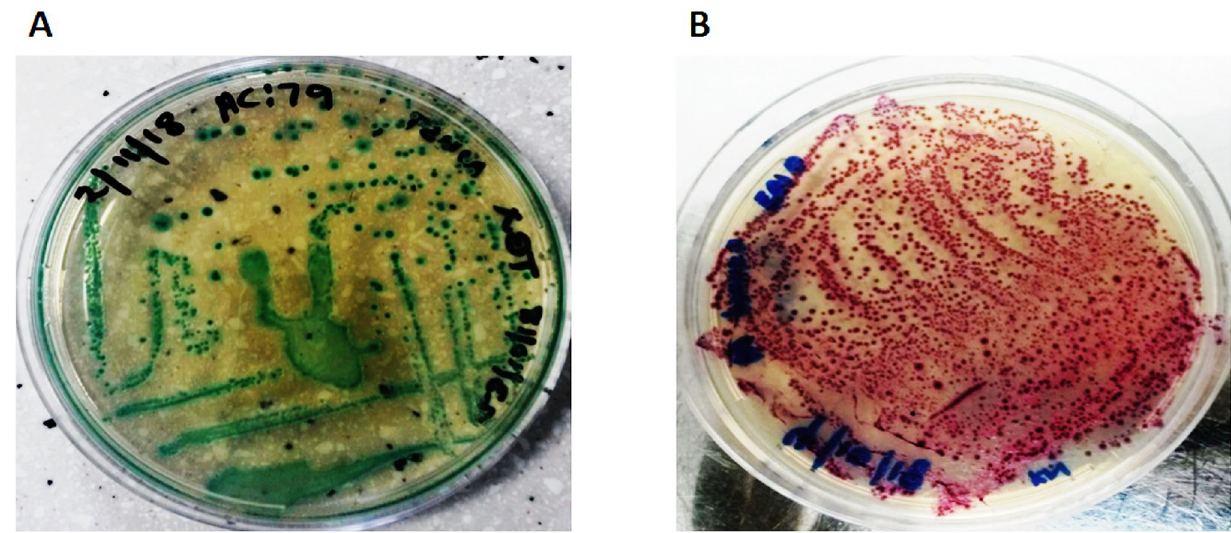
Fig 2. Bacteria culture of E . coli and STEC from both informal and commercial abattoirs. ( A ) E . coli cultures appearing blue-green on TBX plate. ( B ) STEC cultures showing typical mauve colonies on CHROMagar STEC plate.